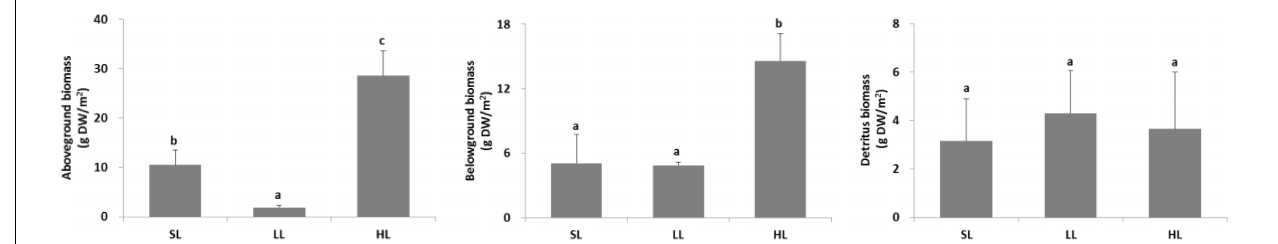
FIGURE 4 | Response of seagrass biomass to light treatments. Saturating light: SL, 200 µ mol photons/m 2 /s; low light: LL, 20 µ mol photons/m 2 /s; high light: HL, 600 µ mol photons/m 2 /s. SL and HL were in the optimal light range between the minimum saturating light and the minimum inhibiting light. Different letters on the bars indicate mean values for a particular light condition that significantly differed at ( p < 0.05) (Mean ± SD, n = 3) analyzed by one-way ANOVA.